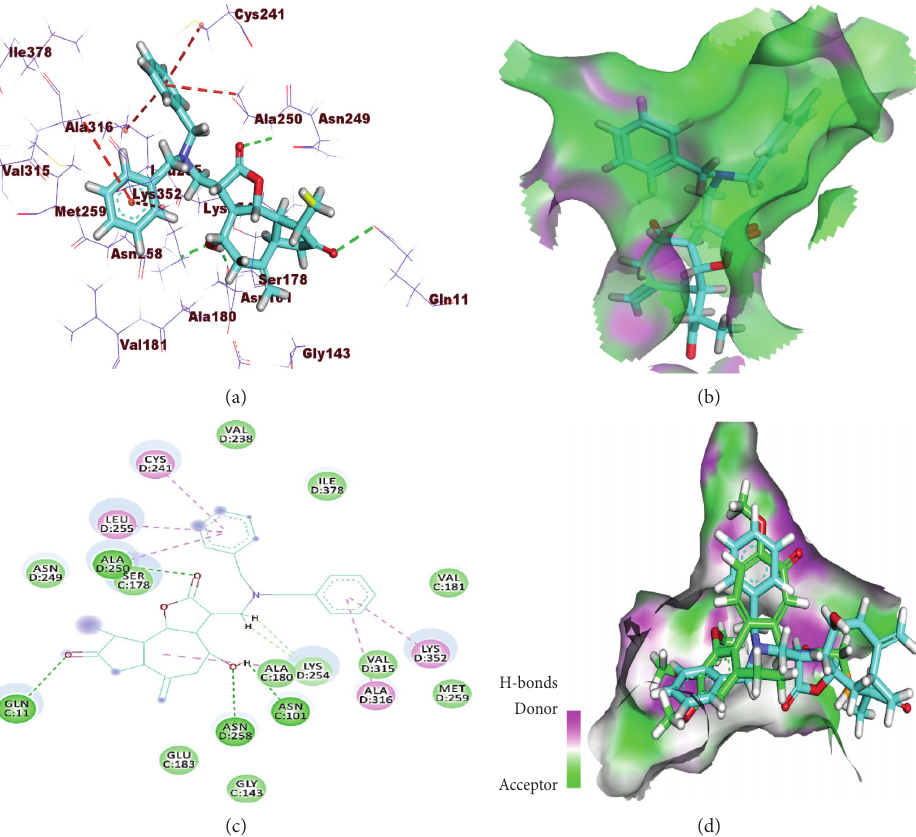
Figure 9: (a) 3D structure of compound 4, docked into the colchicine binding site. (b) Mapping surface showing compound 4, occupying the active pocket of colchicine binding site. (c) 2D structure of compound 4, docked into the colchicine binding site. (d) 3D alignment of compound 4 (carbon atoms in turquoise) with the DAMA-colchicine (carbon atoms in